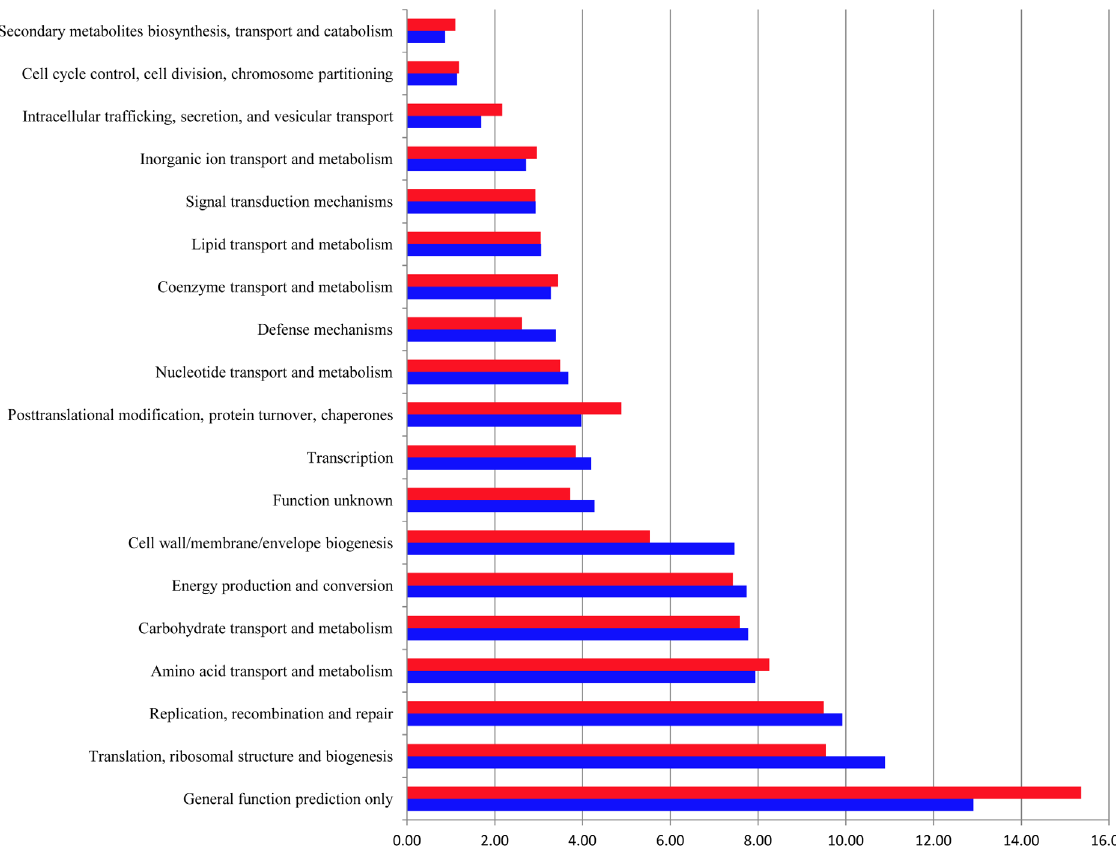
Figure 3. Functional categories affected by RDX exposure to the ovine rumen microbiome, annotated using the COG database. Blue: control ( N =5); Red: RDX exposure ( N =5).